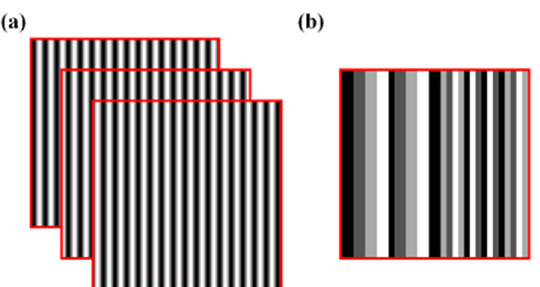
Figure 2. Patterns used in the proposed method. ( a )Three sinusoidal patterns. ( b ) The coded pat- tern.